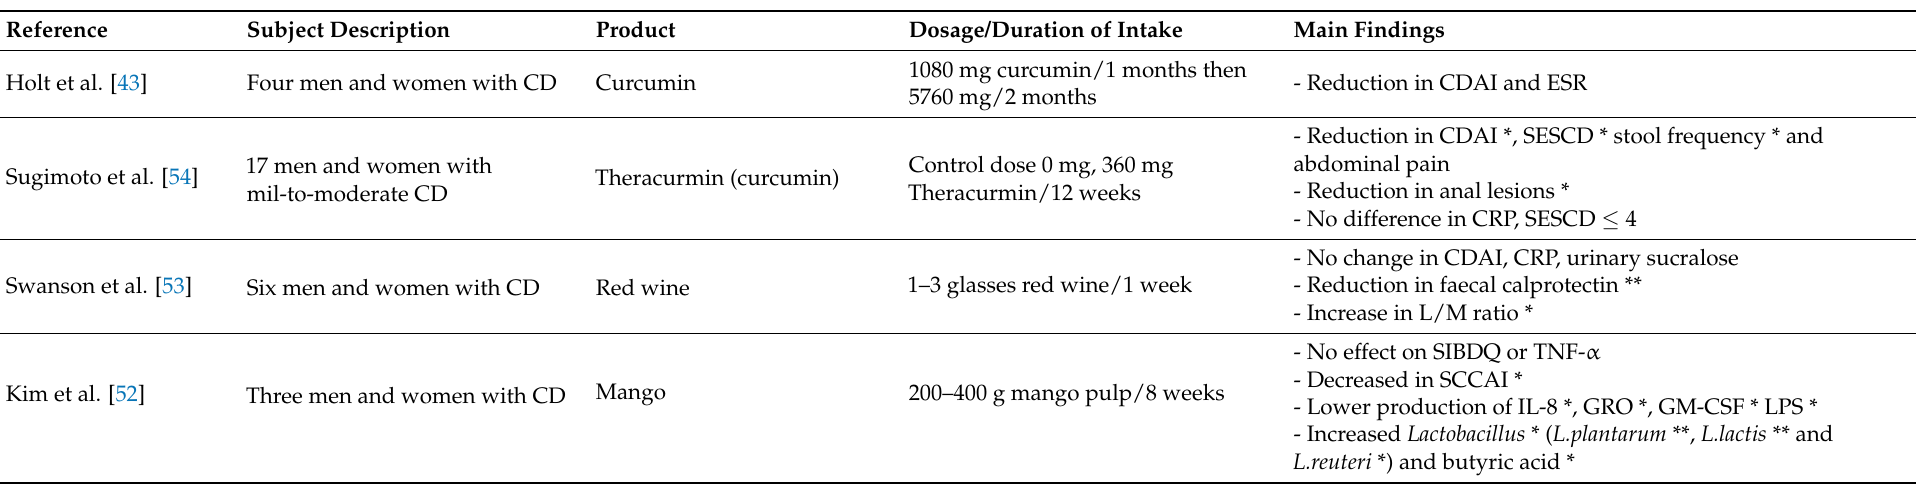
Table 2. Summary of human intervention studies of (poly)phenols in Crohn’s disease